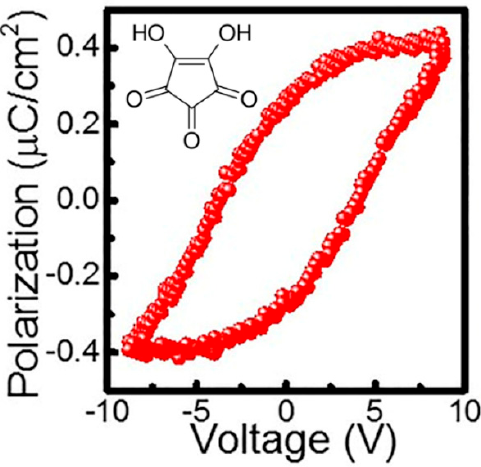
Figure 3. The polarization hysteresis of a 185 nm thick ferroelectric croconic acid thin film. Adapted with permission from ref. [90]. Copyright 2016, the American Institute of Physics.